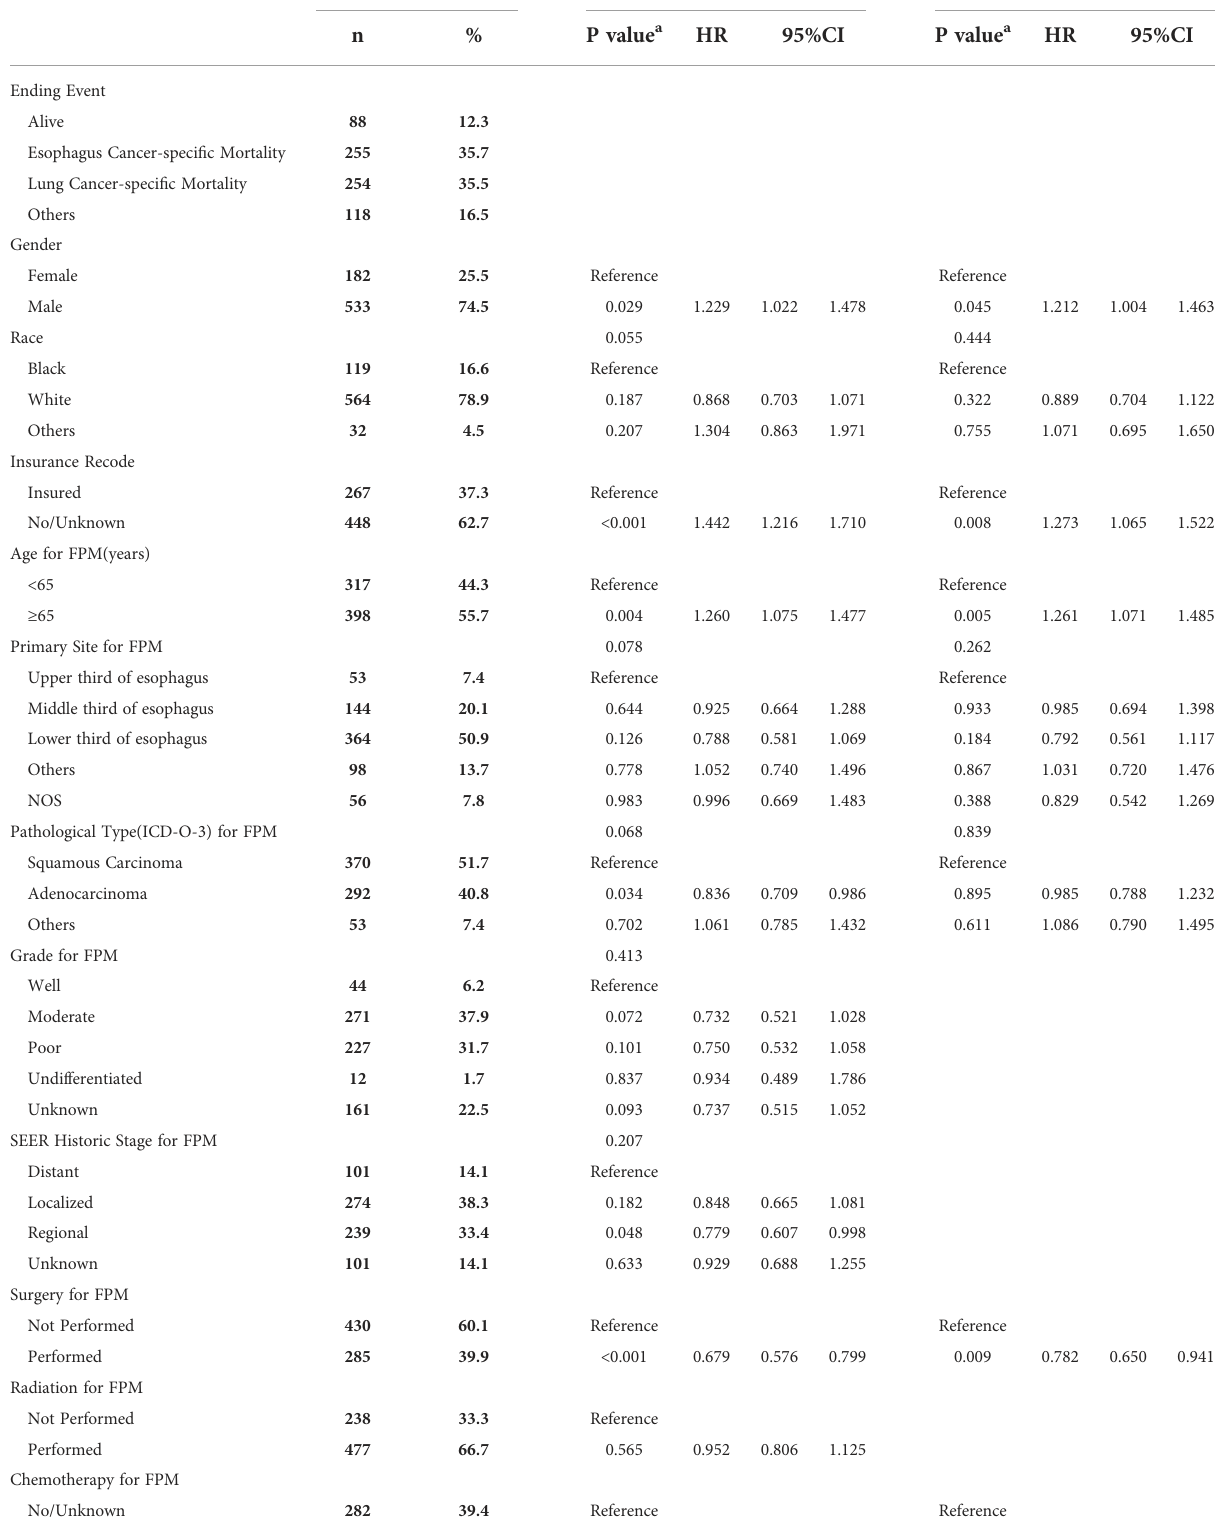
TABLE 1 Characteristics and Variables of SPLC-EC Patients Associated with OS According to the Cox Proportional Hazards Regression